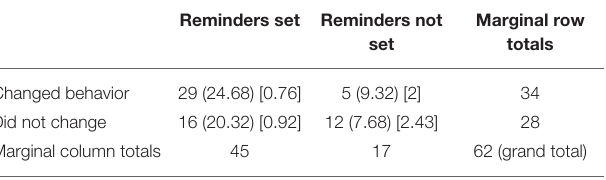
Table information is provided as follows: observed cell totals (expected cell totals) [chi-square statistic for each cell].